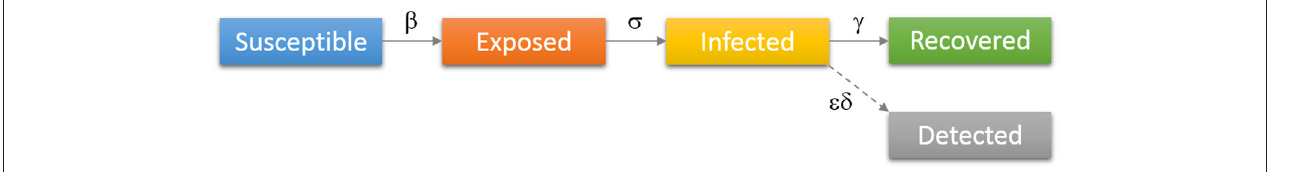
FIGURE 2 | Diagrammatic representation of the SEIR model with the added class of “Detected” patients. Individuals move (denoted by solid arrows) from Susceptible to Exposed to Infected to Recovered, with the rates indicated above arrows in the figure. Some of the infected are detected (diagnosed/confirmed), indicated by the dashed